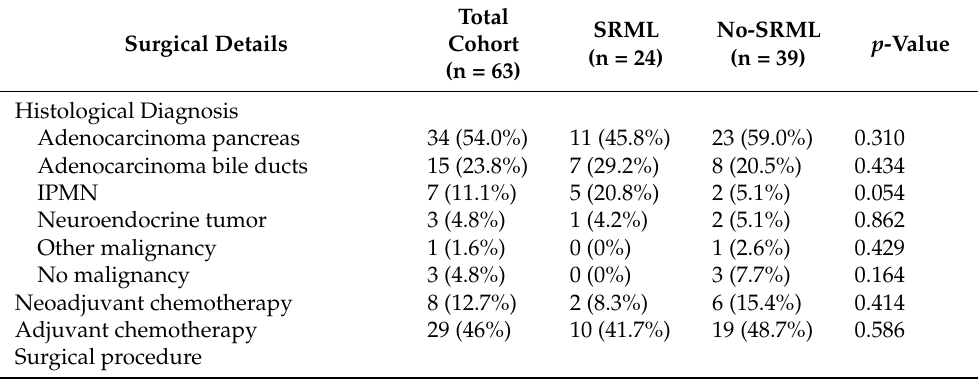
Figure 2. Dynamic changes of mean (SD) postoperative muscle diameter of bilateral m. biceps brachii, m. vastus intermedius and m. rectus femoris measured by ultrasound at baseline, 3, 7 and 10 days after pancreatic surgery compared between the presence of clinically relevant SRML. Table 2. Surgical details compared between the presence of clinically relevant